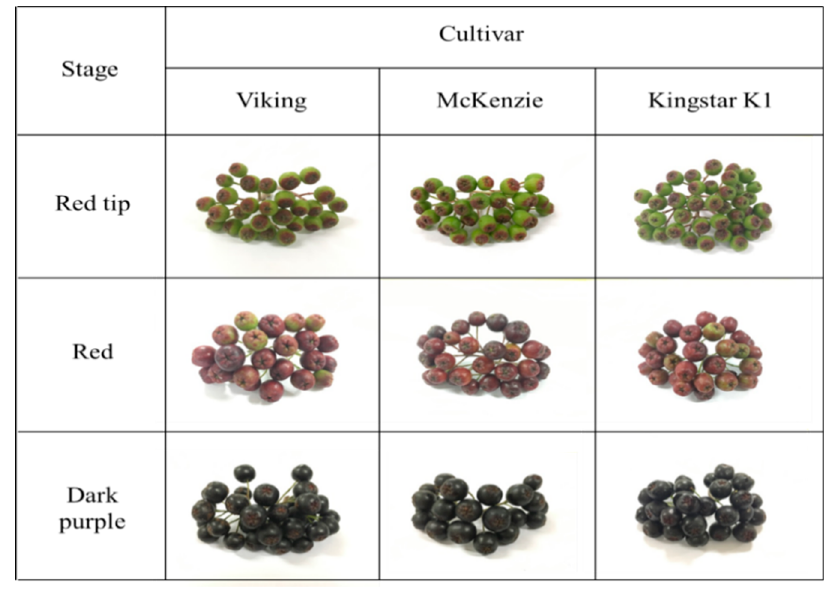
Figure 1. Color and appearance of Aronia melanocarpa fruits at different maturity stages.